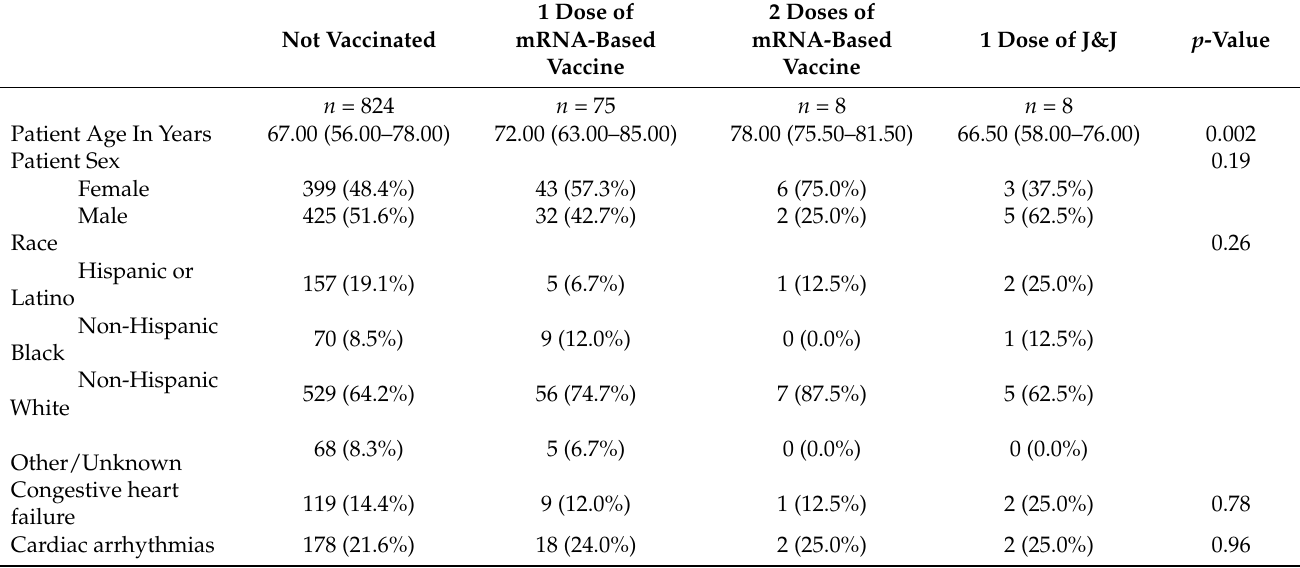
Table 1. Patient Baseline